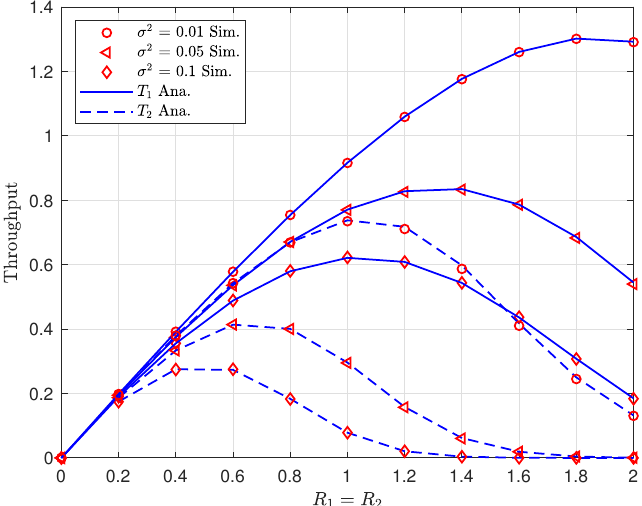
Figure 8. Throughput of system vs. the target rate R 1 = R 2 .